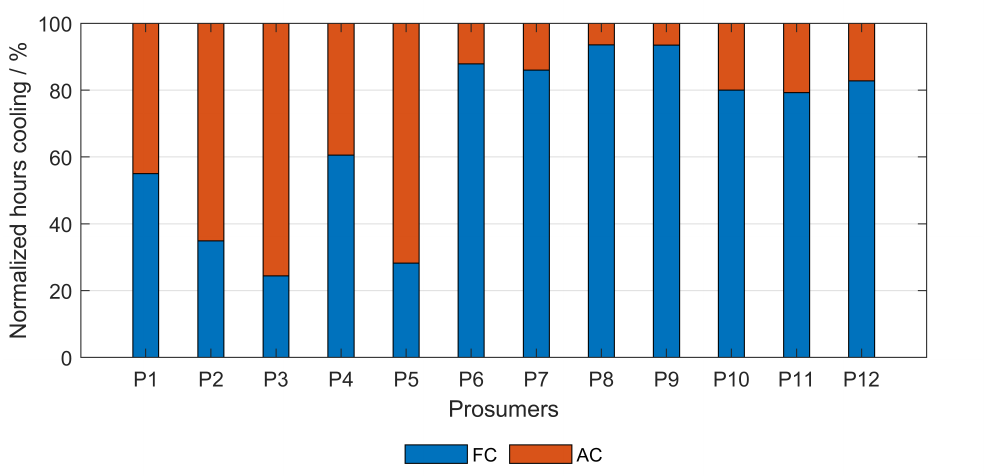
Figure 16. Normalized share of FC and AC for the prosumers